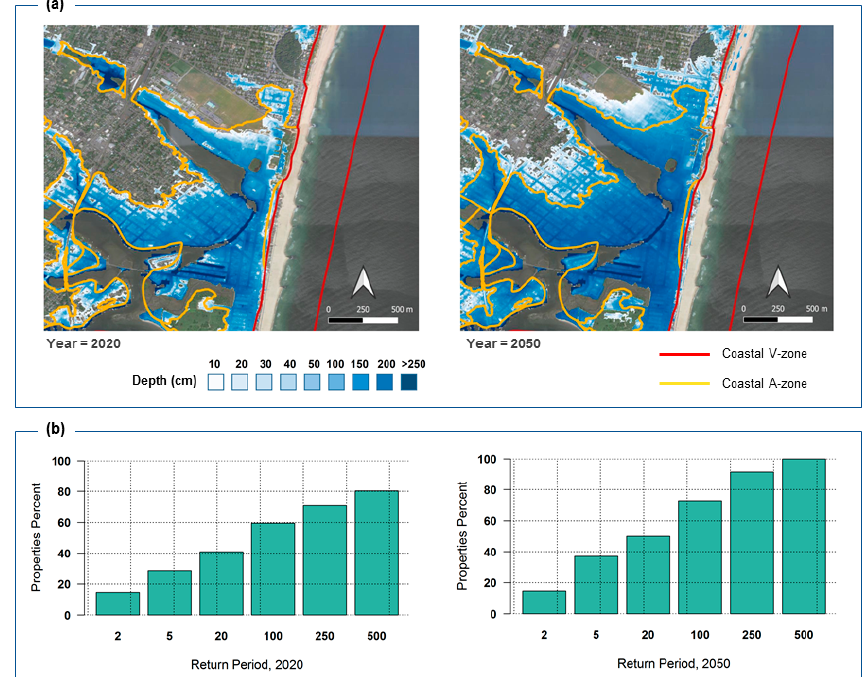
Figure 1. Panel ( a ) compares the 100-yr flood depth and extent of the flooding in 2020 and 2050 in part of Ocean County, panel ( b ) indicates the percentage of properties impacted by different return periods.